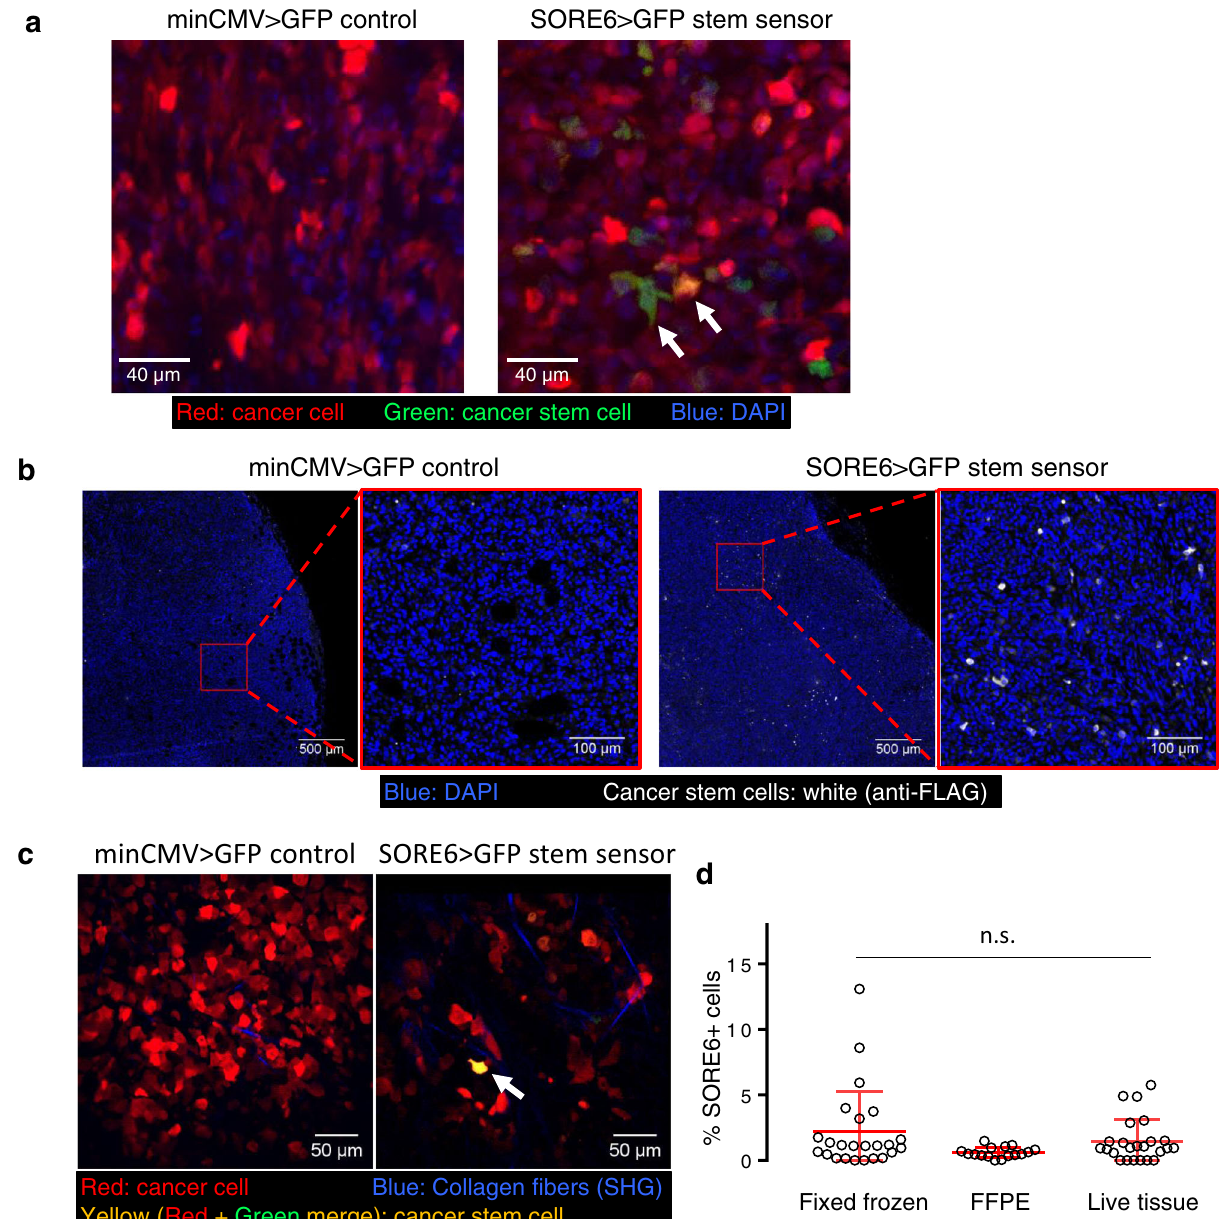
Fig. 1 Breast carcinoma stem cells are a minority population in the primary tumor in vivo. a Representative images of fi xed-frozen tumor tissues. Left panel: tdTomato-minCMV>GFP vector control tumor tissue; right panel: tdTomato-SORE6>GFP reporter MDA-MB-231 tumor tissue. Arrows point to two examples of GFP + /SORE6 + stem cells, which appear green to yellow due to varying levels of tdTomato (volume marker) intensity in the cell. b In situ immuno fl uorescence staining for the FLAG tag (white) on the GFP reporter in FFPE tumor tissues identi fi es SORE6 + stem cells as a minority population in fi xed tissues in SCID host. Two left panels: tdTomato MDA-MB-231 minCMV>GFP vector control tumor tissue; two right panels: tdTomato MDA-MB-231 SORE6>GFP reporter tumor tissue. Nuclei were stained with DAPI (blue). c Intravital multiphoton microscopy identi fi es SORE6 + stem cells as a minority population (white arrow) in living mouse. Left panel: tdTomato MDA-MB-231 minCMV>GFP vector control tumor tissue; right panel: tdTomato MDA-MB- 231 SORE6>GFP reporter tumor tissue. SHG: second harmonic generation. d Quanti fi cation of % SORE6 + stem cells in breast tissue using the three different methodologies described in a – c . n = 24 fi elds of 330 × 330 µ m 2 from 3 mice for fi xed-frozen tissues; n = 16 fi elds of 500 × 500 µ m 2 from 3 mice for FFPE tissues; n = 24 fi elds of 340 × 340 µ m 2 from 3 mice for live tissue. Scatter plot showing mean ± SD, one-way ANOVA n.s. p =